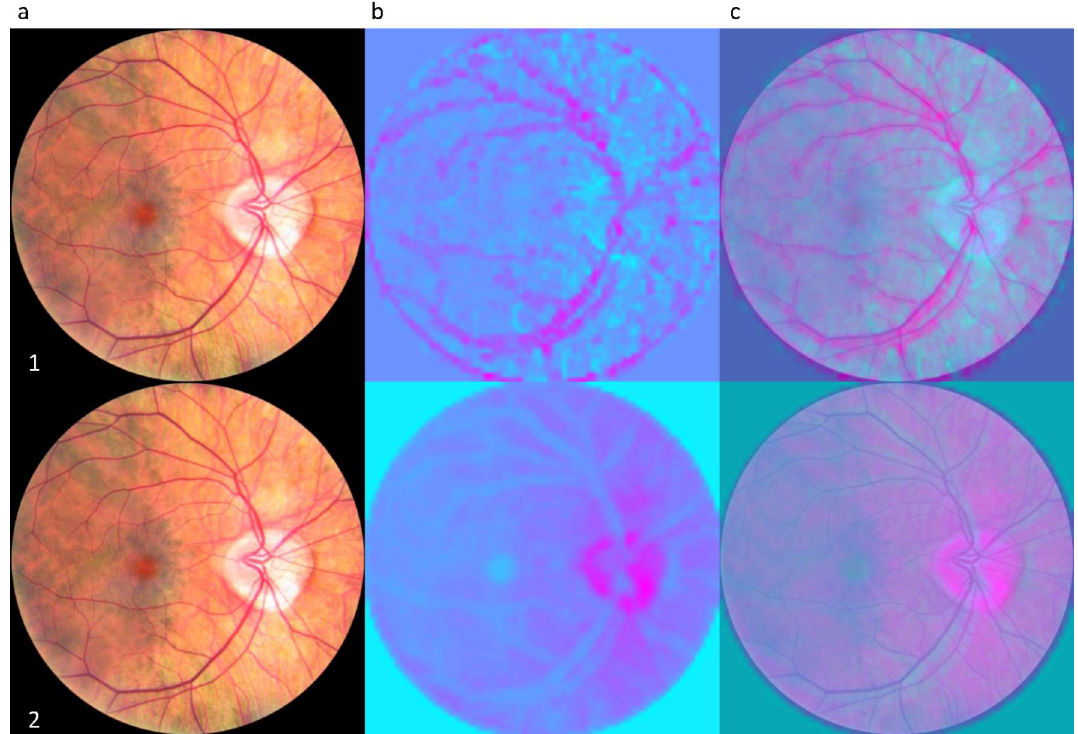
Figure 3. Saliency maps highlighting where the network focus when predicting age (1) and global cognition (2). Column ( a ) is the input image, ( b ) is the saliency map and ( c ) is the overlap of ( a ) and ( b ). The pink regions on the saliency maps are the one having influence in making the prediction while blue regions had lower importance. Highlighted regions were noted from 100 randomly selected images. For global cognition, the ONH was highlighted in 94% of sampled images, the background was highlighted in 44% of images, the vessels were highlighted in none of the images (0%) and non-specific regions (non-specific feature, edge of retinal scans, etc.) were highlighted in 24% of images. Regarding age, the ONH was highlighted in 1% of images, the background was highlighted in 2% of images, the vessels were highlighted in 89% of the images and non-specific regions were highlighted in 9% of